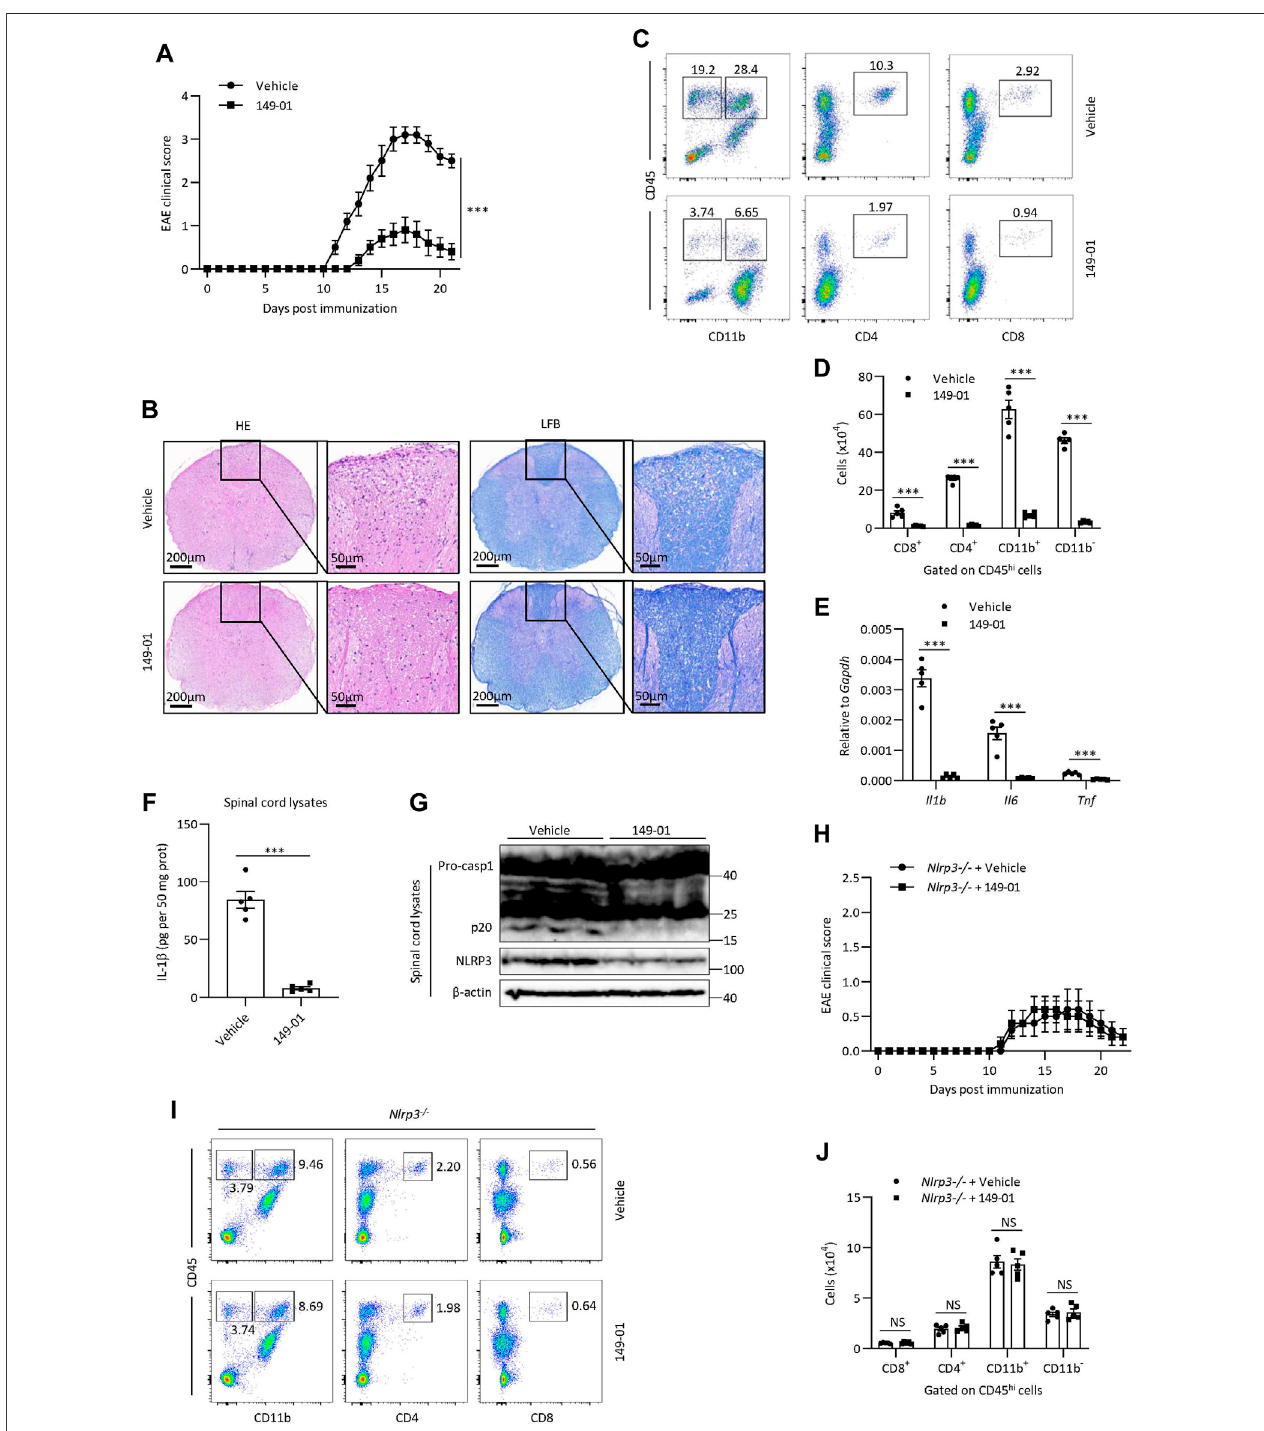
FIGURE 7 | 149-01 attenuates the progression of EAE via inhibition of NLRP3 in fl ammasome. (A – G) Mice were intraperitoneally injected with 149-01 (5 mg/kg) or vehicleon thedayofEAEinductionand every2 days thereafter. (A) EAEclinicalscores. (B) Representativespinalcord sections werestainedwithH&Eor Luxolfastblue (LFB) to visualize in fl ammatory cell in fi ltration or demyelination at day 14 after EAE induction. (C,D) The percentages of representative plots (C) and total numbers (D) of in fi ltrated CD8 + , CD4 + , CD11b + and CD11b − cells gated on CD45 hi cell populations in the CNS were determined by FACS at day 14 after EAE induction. (E) The expression of indicated in fl ammatory cytokines in the CNS were detected by qPCR at day 14 after EAE induction. (F,G) The protein levels of IL-1 β , caspase-1 and NLRP3 in the spinal cords were detected by ELISA (F) or western blot (G) at day 14 after EAE induction. (H – J) Nlrp 3 − / − mice were intraperitoneally injected with 149-01